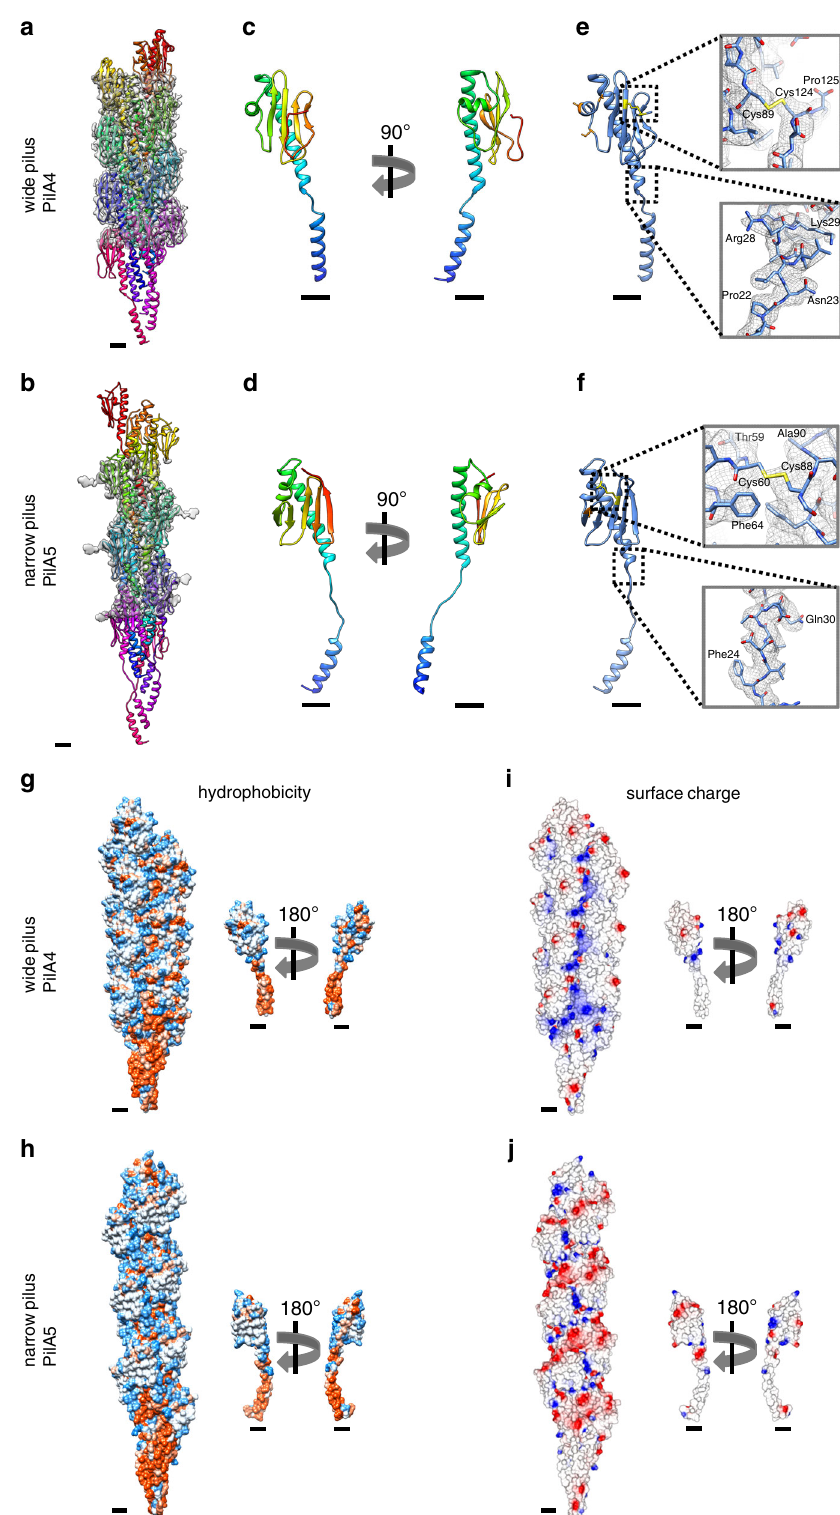
Fig. 3 Atomic models of wide and narrow pili. a , b Models of short sections of fi laments (15 subunits each) with the corresponding EM density maps. a wide pilus comprised of PilA4; b narrow pilus comprised of PilA5. Scale bars, 10 Å. c , d Ribbon representation of a single PilA4 ( c ) and PilA5 ( d ) subunit. N-terminus blue, C-terminus red. Scale bars, 10 Å. e , f Ribbon representation of a single PilA4 ( e ) and PilA5 ( f ) subunit with selected sidechains shown. Yellow, disulphide bond; orange, serines with post-translational modi fi cation. Insets show details of the atomic model within the EM density map. Top insets, disulphide bond; bottom insets, side chain densities. Scale bars, 10 Å. g , h Hydrophobicity patterns of PilA4 ( g ) and PilA5 ( h ) fi laments (left) and single subunits (right). Hydrophobic (red) and hydrophilic (blue) residues are shown. Scale bars, 10 Å. i , j Electrostatic surface charge of PilA4 ( i ) and PilA5 ( j ) fi laments (left) and single subunits (right). Negative charges (red) and positive charges (blue) are shown. Scale bars, 10